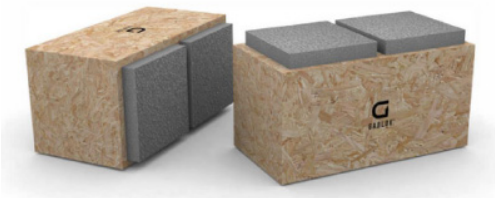
Figure 7. Gablok wooden box elements [11].